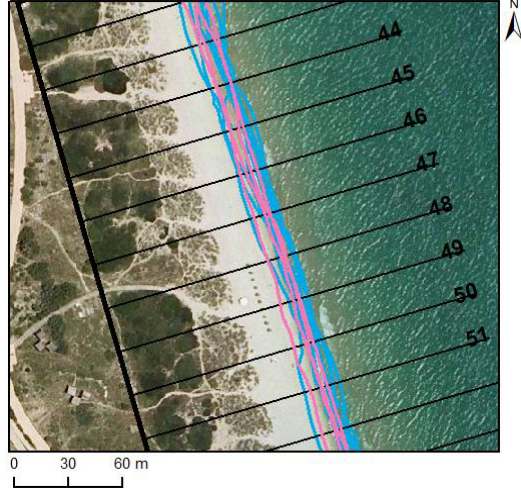
Figure 4. Application example of DSAS. Transects and baseline are shown in black and, in blue and pink, coastlines of Landsat and high precision respectively (studied period